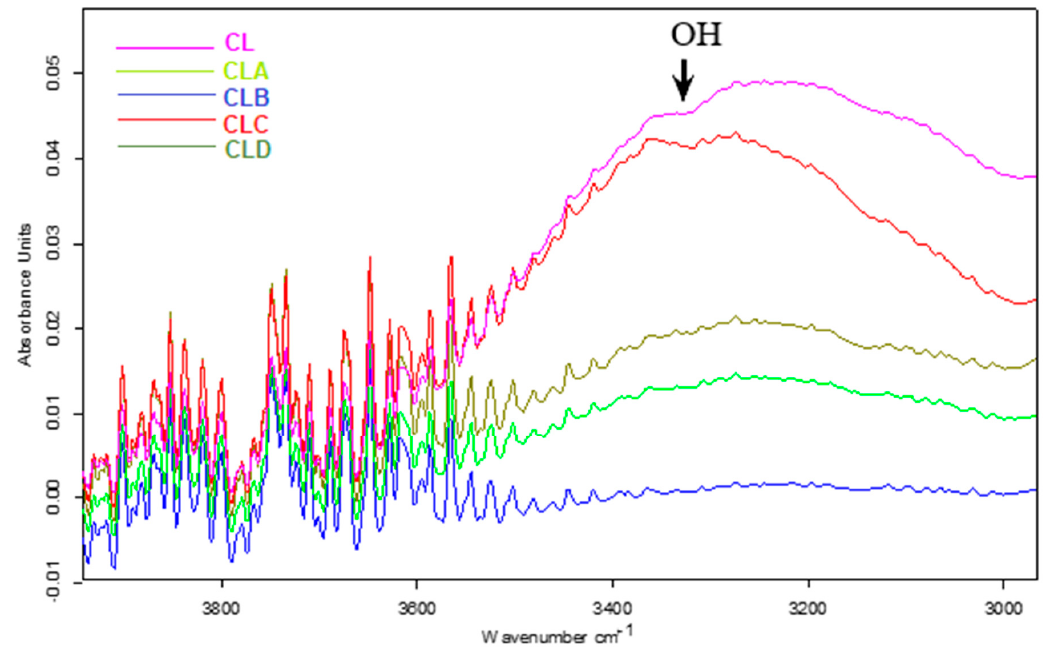
Figure 2. FT-IR characterization spectra of chitosan based nanoparticles and its derivatives (CL, CLA, CLB, CLC, and CLD).